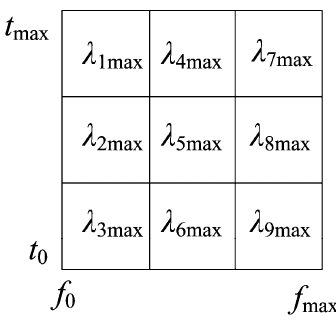
Figure 11. Schematic diagram of the submatrix division.